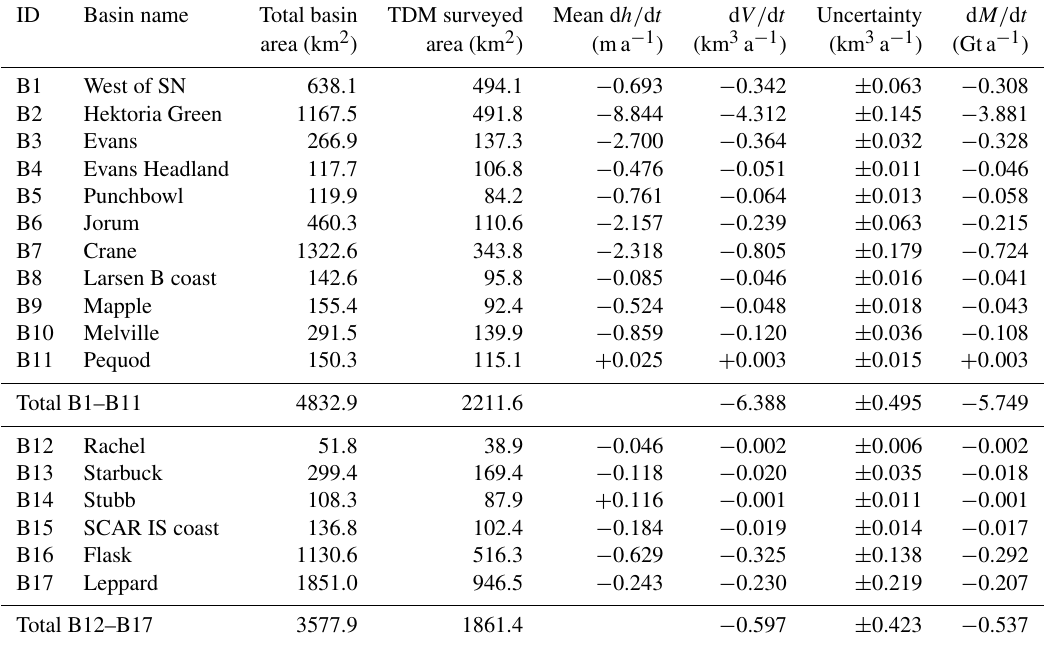
Table 4. Rate of surface elevation change for areas by means of TDM DEM differencing from 2011 to 2013 for glacier basins of the Larsen B embayment. d h/ d t is the mean rate of elevation change in the area covered by the high-resolution map (Fig. 6). The basin area refers to ice front positions delineated in TanDEM-X images of 20 June and 1 July 2013. The rates of ice volume change (d V/ d t ) and total mass balance (d M/ d t ) refer to grounded